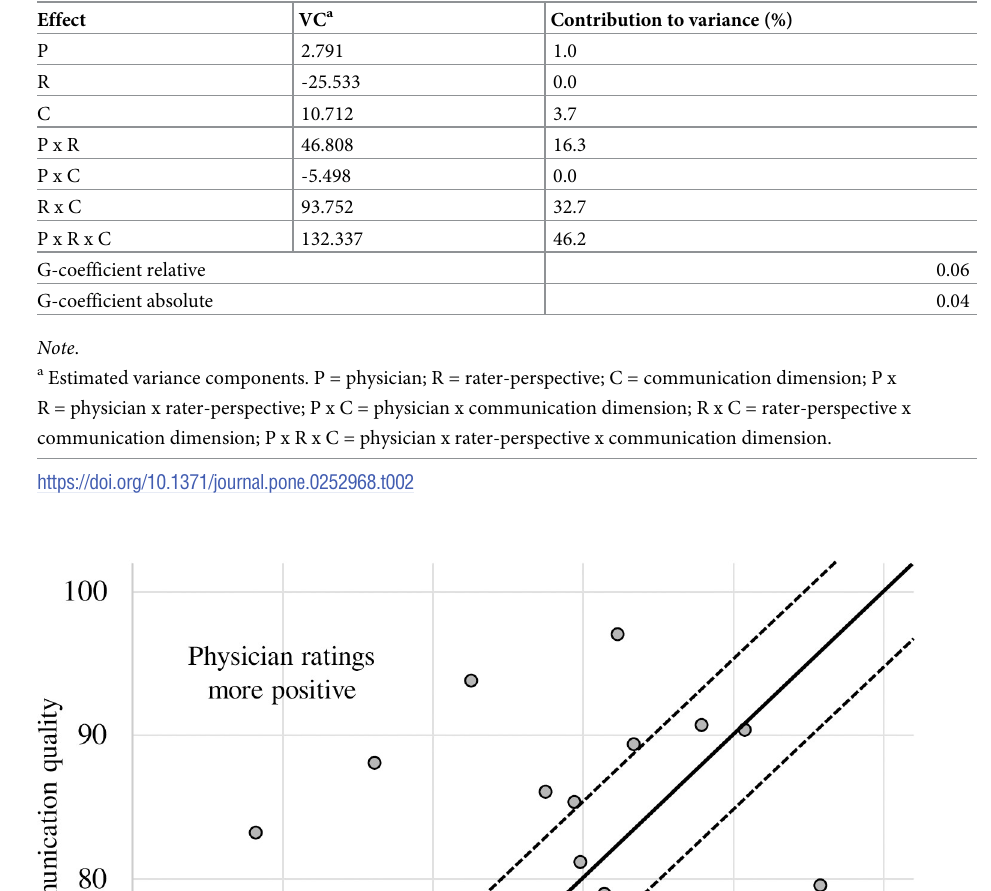
Table 2. G-study estimates of variance components and